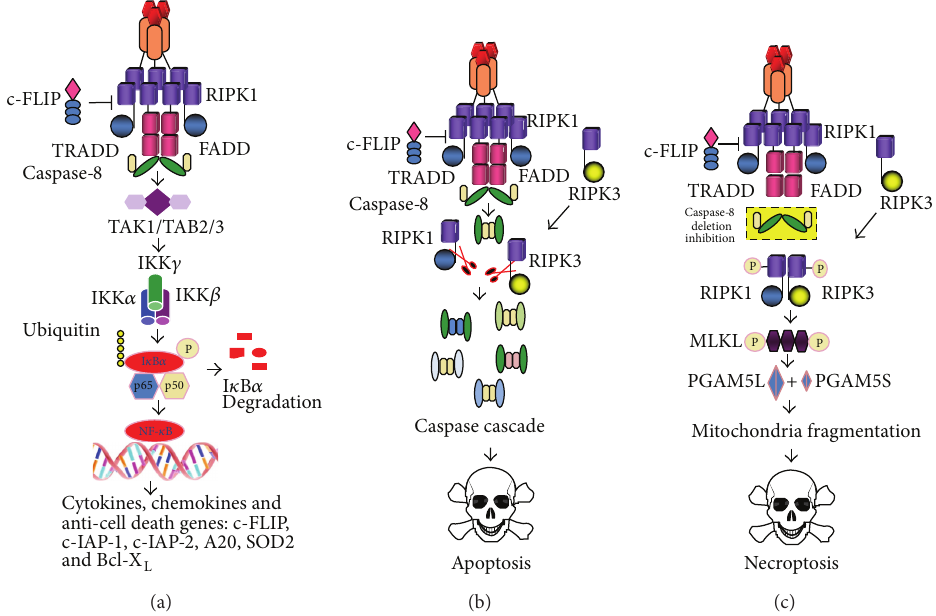
Figure 4: Schematic overview of TNF- 𝛼 -induced signaling pathways to activation of NF- 𝜅 B (a), apoptosis (b), and necroptosis (c). TNF- 𝛼 binding to TNFR causes the assembly of a membrane-proximal supramolecular complex including (but not limited to) TRADD, FADD, TRAF2/5 (TNFR associated factor 2/5), cIAP1/2 (cellular inhibitor of apoptosis 1/2), and RIPK1 (receptor interacting protein kinase). RIPK1 causes the phosphorylation and activation of TAK1/TAB2/3 which in turn promote the phosphorylation of the inhibitor of NF- 𝜅 B (IKK subunits 𝛼 , 𝛽 , and 𝛾 ). The ubiquitination leads to the proteasome-mediated degradation of I 𝜅 B 𝛼 and release and nuclear translocation of NF- 𝜅 B dimers. Recruitment and activation of caspase-8 play a crucial role in initiation of apoptotic (b) or necrotic cell death (c). Cleavage of both RIP1 and RIP3 by caspase-8 leads to apoptosis, whereas phosphorylation of RIP1 and RIP3 kinases causes the necrosome activation. Similarly, caspase-8 inhibition, or FADD/caspase-8 deletion, or RIPK3 induction leads to necrosome activation. Both RIPK1 and RIPK3 phosphorylate and activate a mixed lineage kinase domain-like (MLKL) and phosphoglycerate mutase family member 5 (PGAM5L and S) which recruit dynamin-related protein 1 (Drp-1), one of the key regulators of mitochondrial fission and mitochondrial fragmentation-dependent signaling pathway leading to